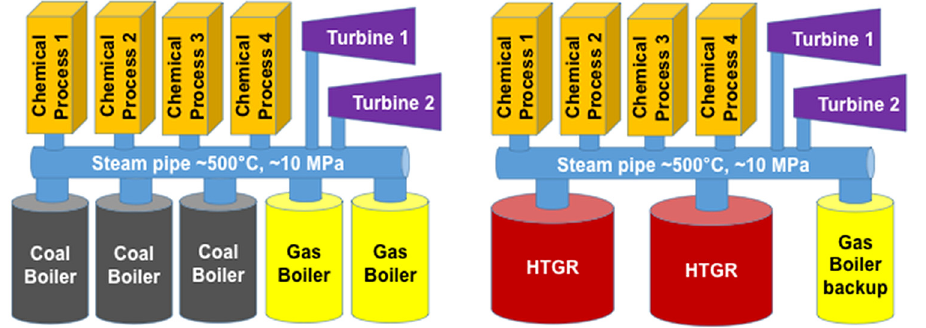
Fig. 4. Replacement of fossil boilers by HTGR.